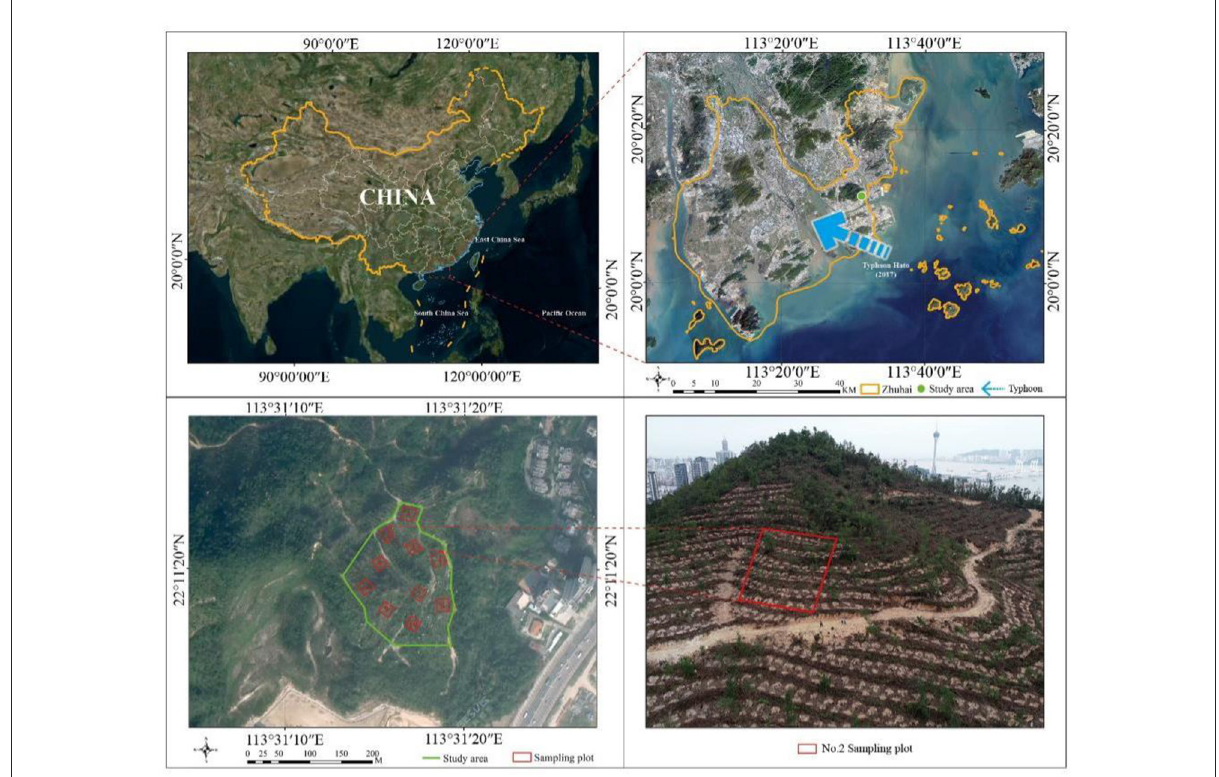
FIGURE1 Schematic location of Zhuhai in China (top left) , Typhoon Hato’ route and study area in Zhuhai (top right) , sampling plots in the study area (bottom left) , and the No.2 sampling plot (bottom right)